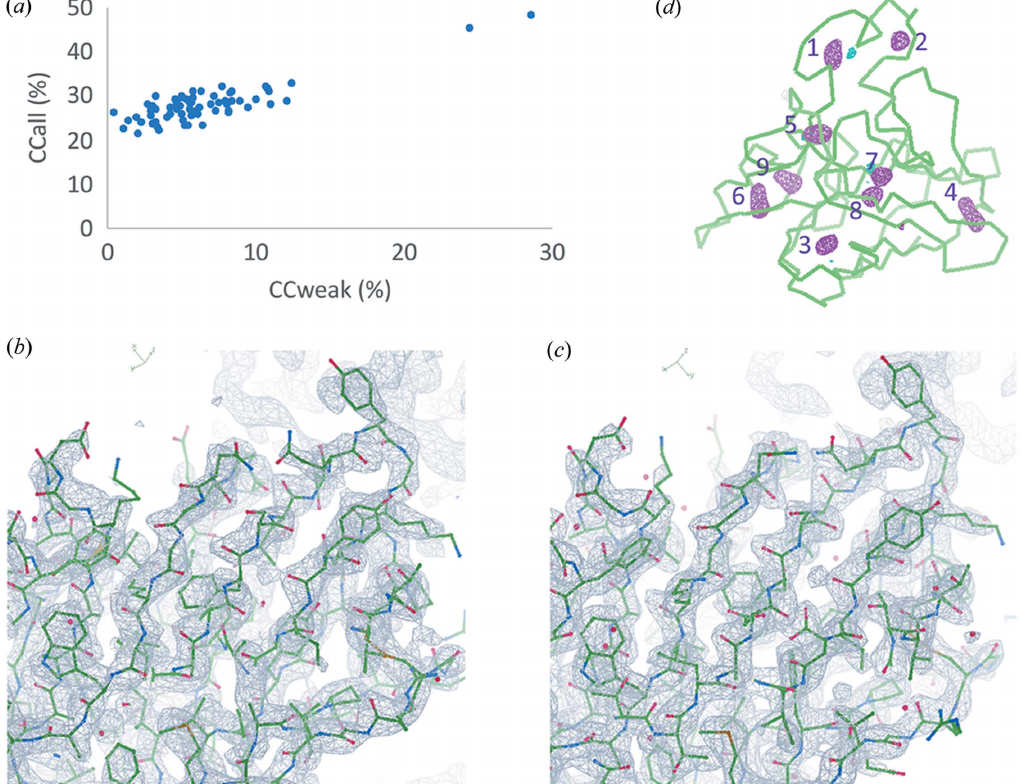
Figure 3 Structure determination and phasing of thaumatin. ( a ) CC all /CC weak of SHELXD trials. ( b ) Experimental electron density after density modification. ( c ) Refined electron-density map. ( d ) Bijvoet-difference Fourier peaks. Peaks for anomalous scatters are shown as magenta isomeshes contoured at 4 (cid:3) . The numbers indicate the positions of sulfur atoms of anomalous scatters in the structure: 1, C149–C158; 2, C159–C164; 3, C9–C204; 4, C121–C193; 5, C134– C145; 6, C56–C66; 7, C126–C177; 8, M122; 9, C71–C77. The overall structure model of thaumatin from native-SAD is shown as ribbons.